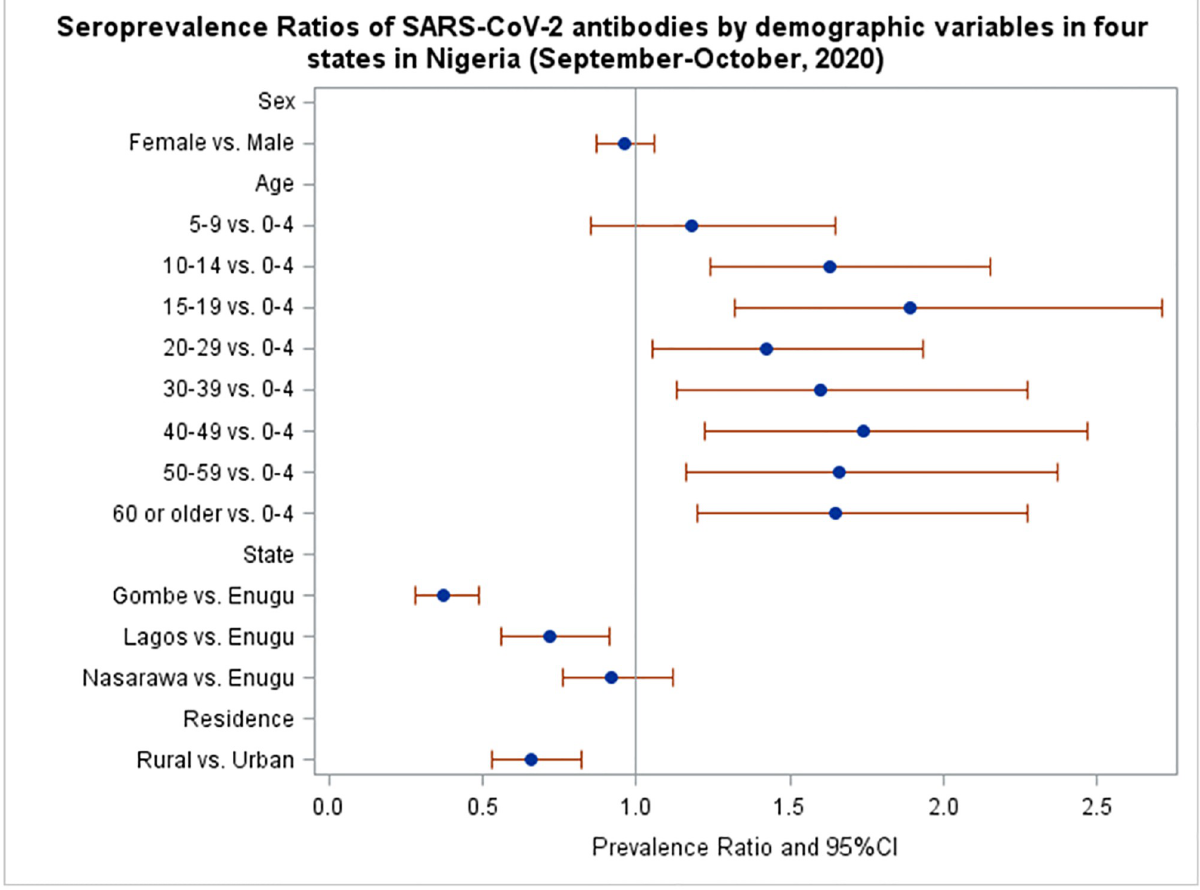
Fig 1. Unadjusted seroprevalence ratios for the presence of SARS-CoV-2 antibodies by demographic variables from four states in Nigeria (October